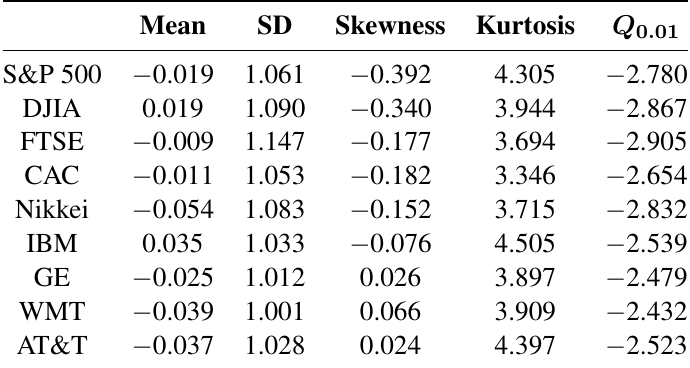
Table 2. Descriptive statistics for returns standardized by in-sample realized volatility fitted values.